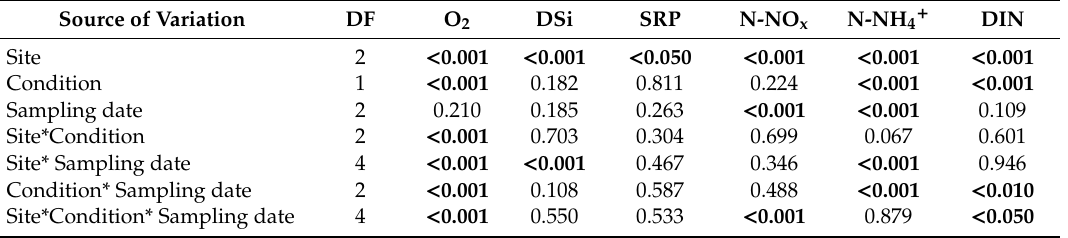
Figure 3. Light and dark oxygen fluxes (O 2 ) and gross primary production (GPP) measured in the three sampling sites in the different sampling dates. Error bars represent standard error (n = 6). Legend: RS = rocky shores; VS = vegetated sediments; BS = bare sediments. Table 5. Summary of the results of two-way generalized least square (GLS) models of benthic oxygen (O 2 ), dissolved silica (DSi), soluble reactive phosphorus (SRP), nitrate and nitrite (N-NO x ), ammonium (N-NH 4 + ) and dissolved inorganic nitrogen (DIN) fluxes. Significant ( p < 0.05) outcomes are highlighted in